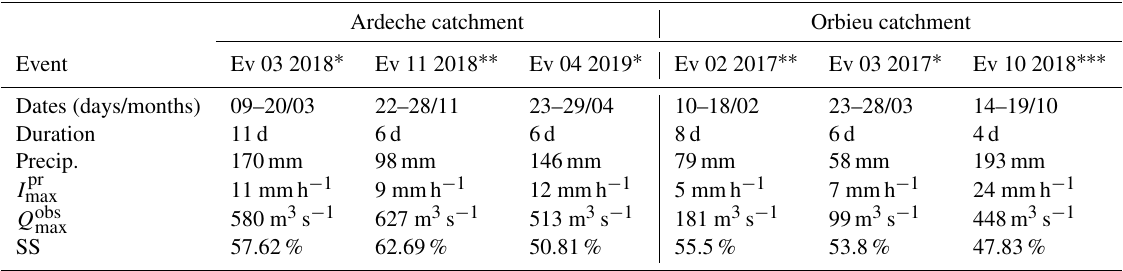
Table 1. The six events considered in this work for the Ardeche catchment in Vogue and the Orbieu catchment in Lagrasse with cumulated volume (Precip.), maximal intensity ( I pr max ) of ANTILOPE QPE, and maximal hourly observed discharge ( Q obs max ). The stars indicate the return period of the flood: ∗ for a 2 year, ∗∗ for a 5 year, and ∗∗∗ for a 100 year return period. The given dates and duration are those considered for the hydrological simulations. SS is the initial SSD provided by the SAFRAN-ISBA-MODCOU chain for the first day of the simulations, on average, over the catchment.